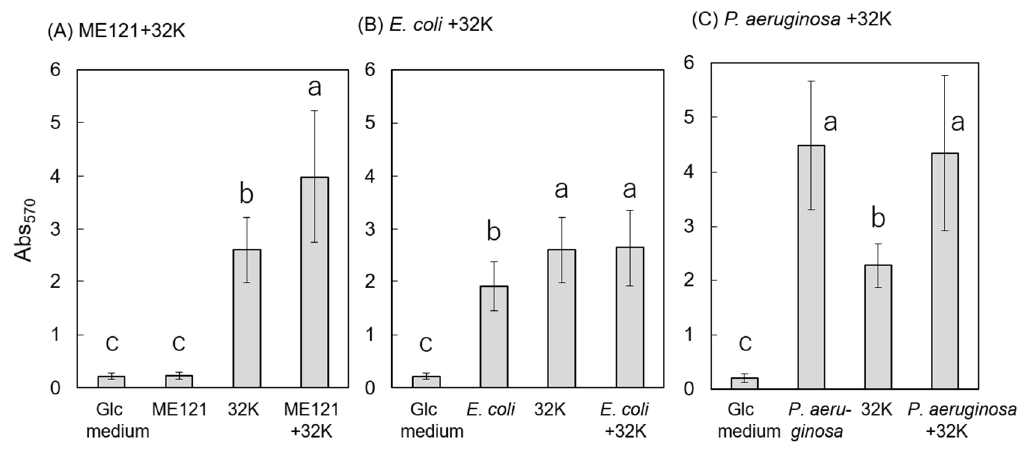
Figure 1. Biofilm formation during cocultivation of strain 32K with test strains . ( A ) Coculture of strains ME121 and 32K, ( B ) coculture of E. coli W3110 and strain 32K, and ( C ) coculture of P. aeruginosa PAO1 and strain 32K. The vertical axis is Abs 570 . Error bars are standard deviations. One-way ANOVA test was performed for equality of all means; ME121 + 32K: F (3, 59) = 98.90, p < 0.01. E. coli + 32K: F (3, 59) = 63.96, p < 0.01, P. aeruginosa + 32K: F (3, 31) = 31.97, p < 0.01. Tukey’s test was performed for post hoc analysis, p < 0.05. Di ff erent superscript letters (a, b, c) denote significant di ff erence from each other in all combinations.